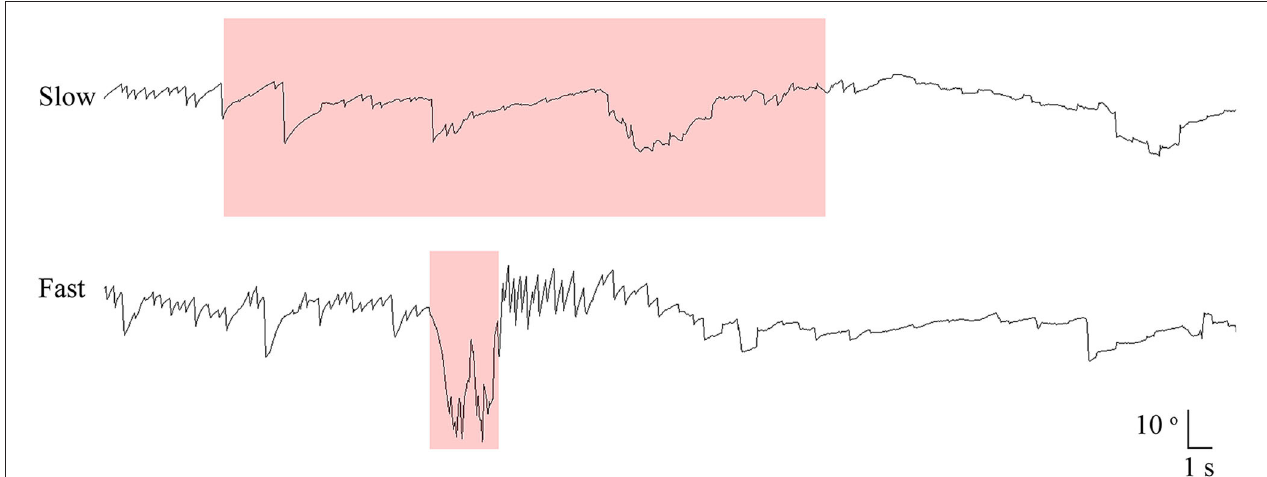
FIGURE 1 | Recording of paroxysmal downbeat nystagmus during manual straight head hanging in patient 21. With slow positioning, no discernable nystagmus was induced, and the pre-existing spontaneous downbeat nystagmus was even suppressed. During fast positioning, in contrast, paroxysmal downbeat nystagmus was induced for several seconds. Only the vertical eye motion is presented and the shaded areas in pink indicate the period of positioning. Upward deflection denotes upward eye motion in each